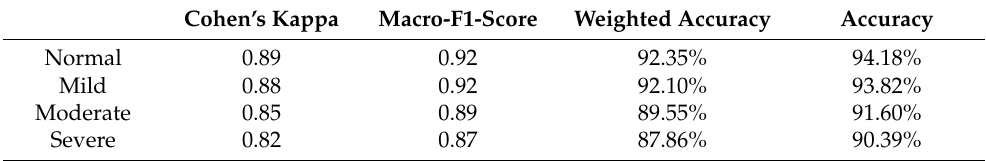
Figure 5. Classification performance of the deep learning model for sleep stage scoring. Confusion matrix showing numbers of samples classified correctly or incorrectly as a percentage: precision and recall values for each case.